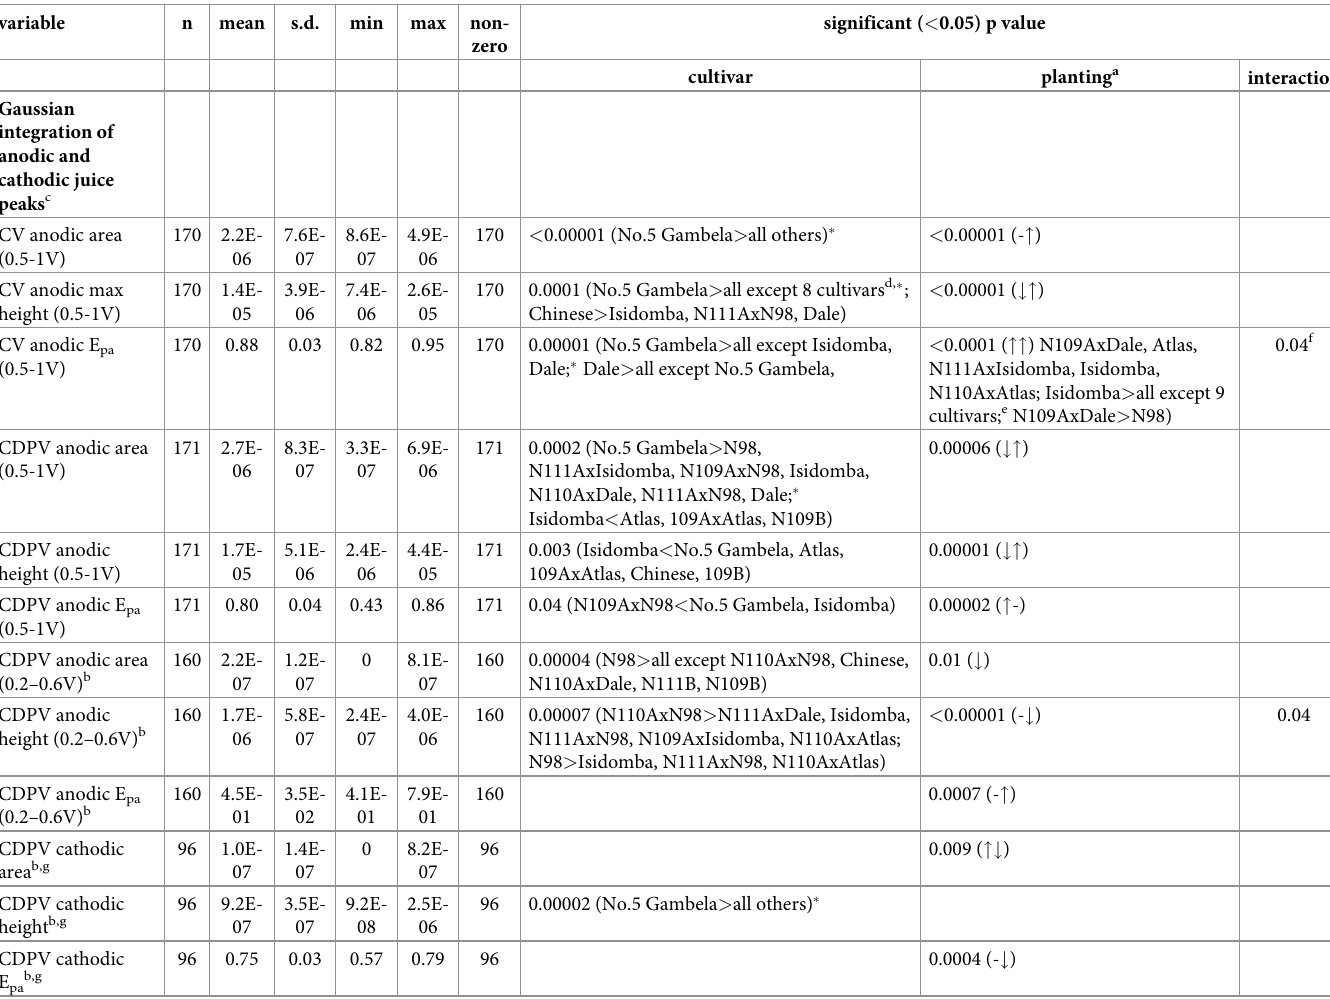
cultivar planting a interaction